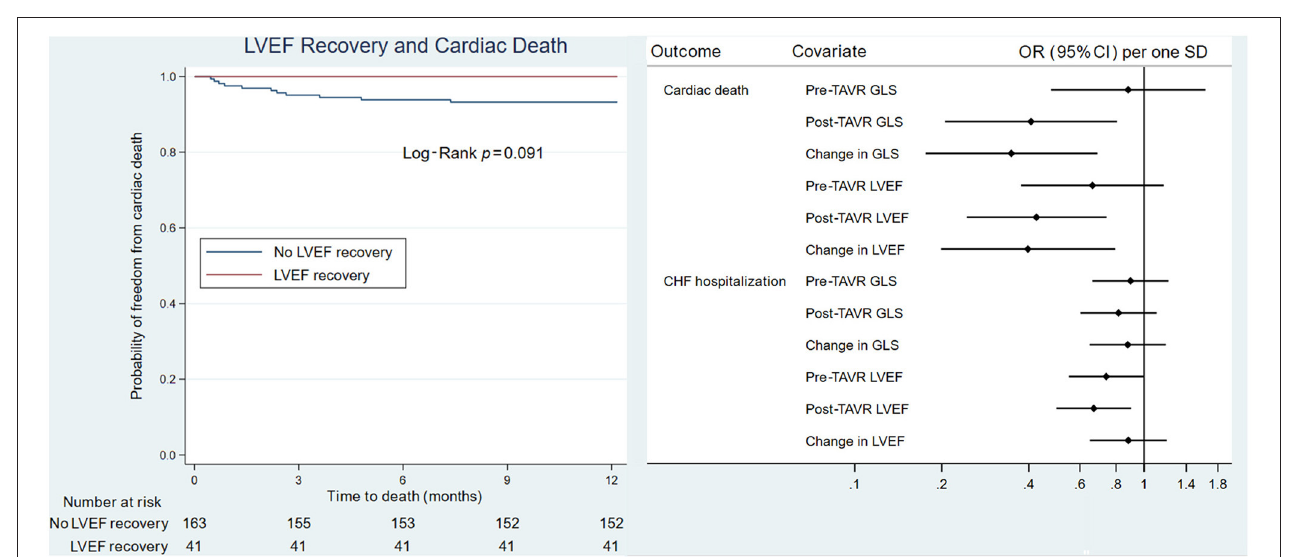
FIGURE 2 | Kaplan-Meier survival analysis of GLS recovery and LVEF recovery. (Left) GLS recovery associated with cardiac death. (Right) LVEF recovery not associated with cardiac death. GLS, global longitudinal strain; LVEF, left ventricular ejection fraction.